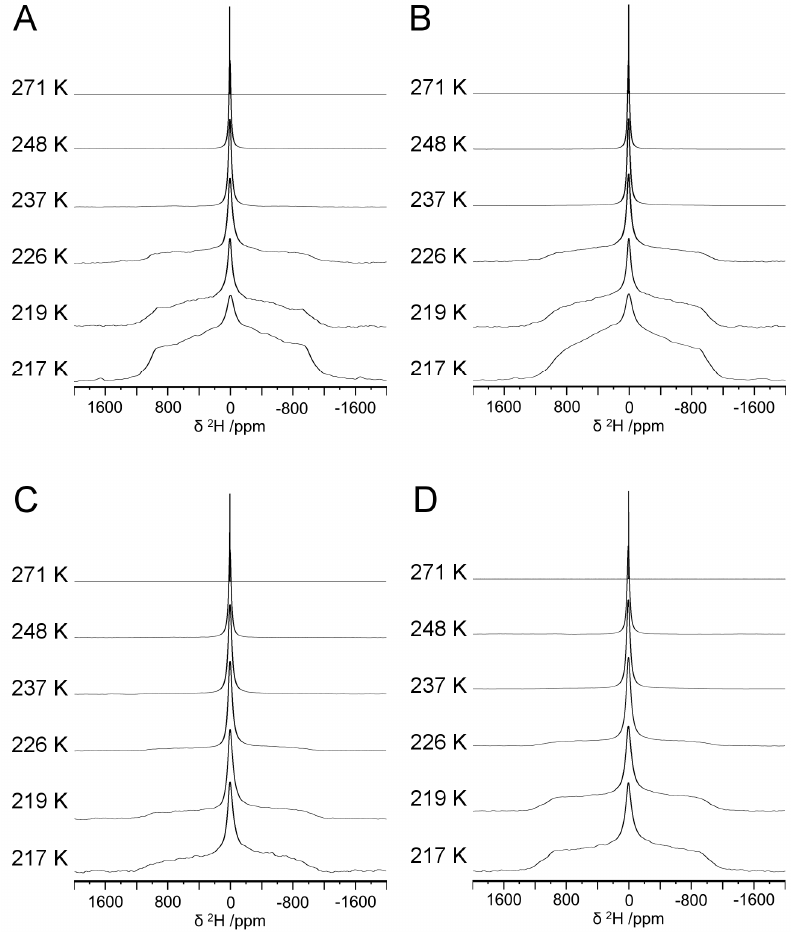
Figure 2. Variable temperature 2 H NMR spectra for (RADA) 4 -based hydrogels formulated as ( A ) 1K0, ( B ) 1K25, ( C ) 5K0, and ( D ) 5K25. All spectra were acquired at 11.75 T ( v 0 = 76.8 MHz).